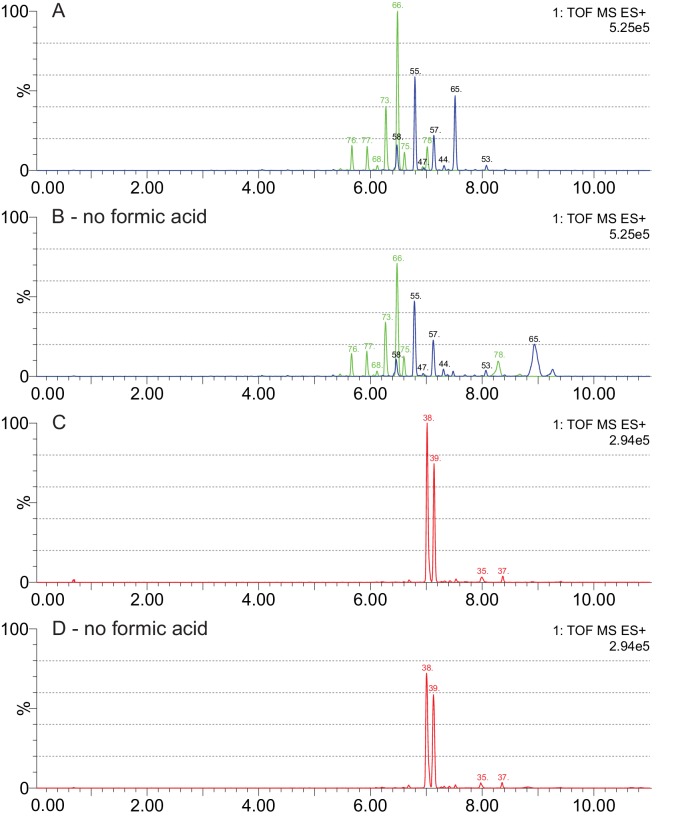
Effects of formic acid as a solvent additive in LC-MS analyses of cardenolide compounds.(A–B) Chromatograms for the same leaf extract of E. bastetanum (BAS) analyzed with and without formic acid in the mobile phase. Shown are fragment traces for formyl-nigrescigenin (449.217 m/z, green) and strophanthidin (405.227 m/z, blue). Both panels share the same scale, and compounds are labelled according to the list in Supplementary file 7. Without formic acid, overall intensity is reduced, but glycosides of formyl-nigrescigenin are consistently detected. In contrast, two compounds with unusual adducts on their glycoside chain (#65 and #78, Supplementary file 7) appear to be changed by formic acid and were removed from the analysis. (C–D) Chromatograms for the same leaf extract of E. repandum (REP) analyzed with and without formic acid in the mobile phase. Shown are fragment traces for formyl-cannogenol (419.243 m/z, red). Both panels share the same scale, and compounds are labelled according to the list in Supplementary file 7.